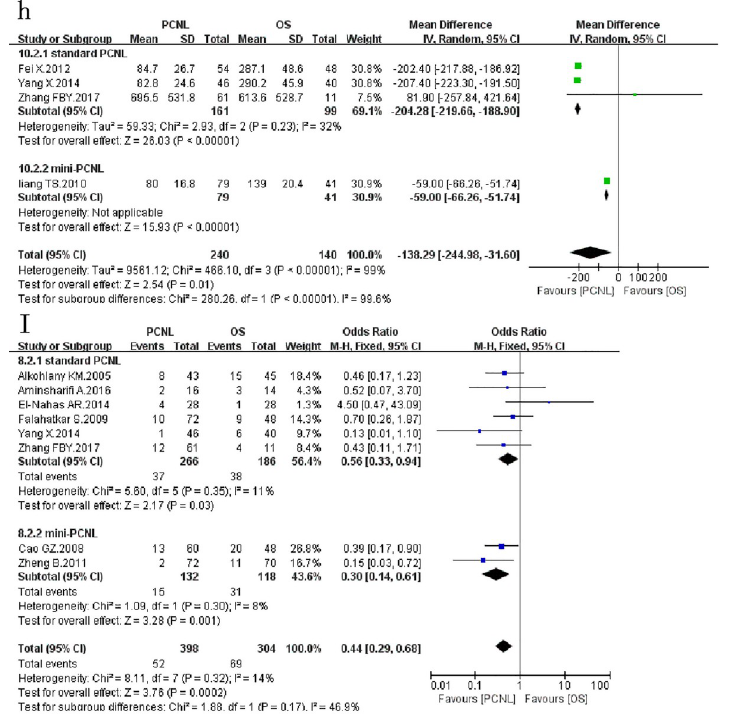
Fig 5. Forest plot and meta-analysis of blood loss(h) and blood transfusion(I).